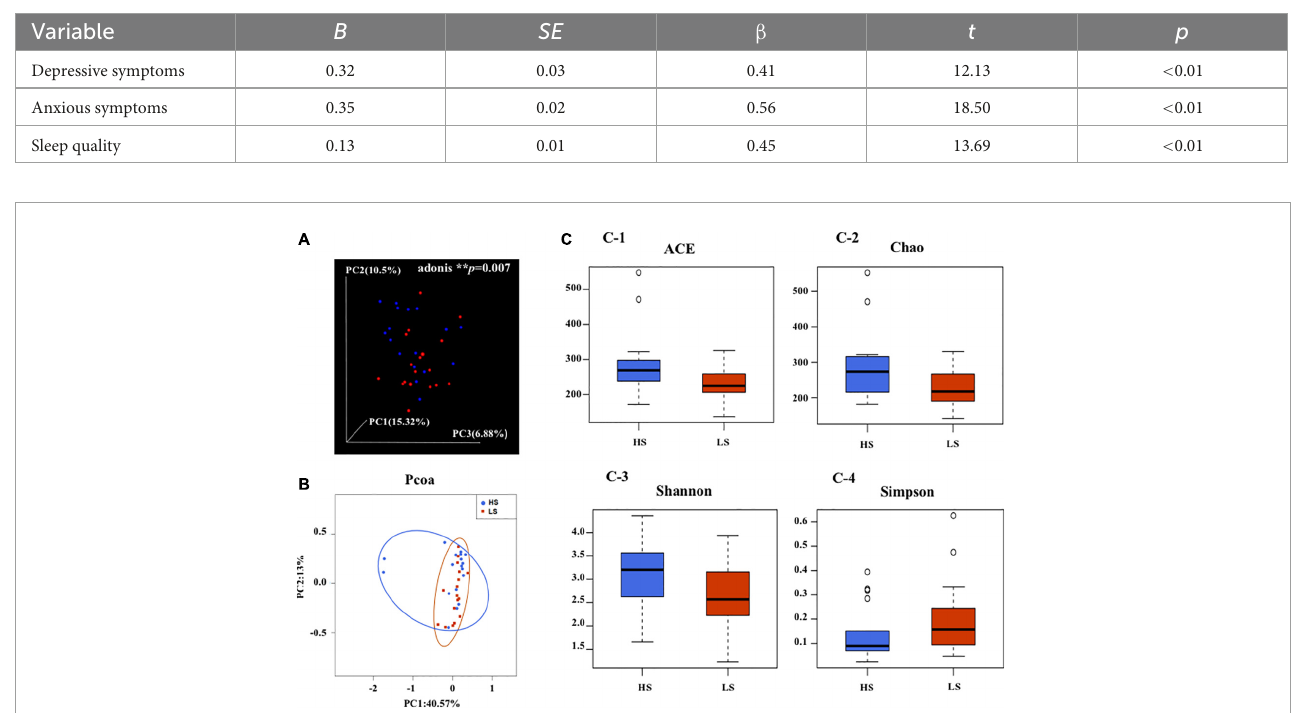
TABLE 2 Regression analysis of NCPB on depressive symptoms, anxiety symptoms, and sleep quality.